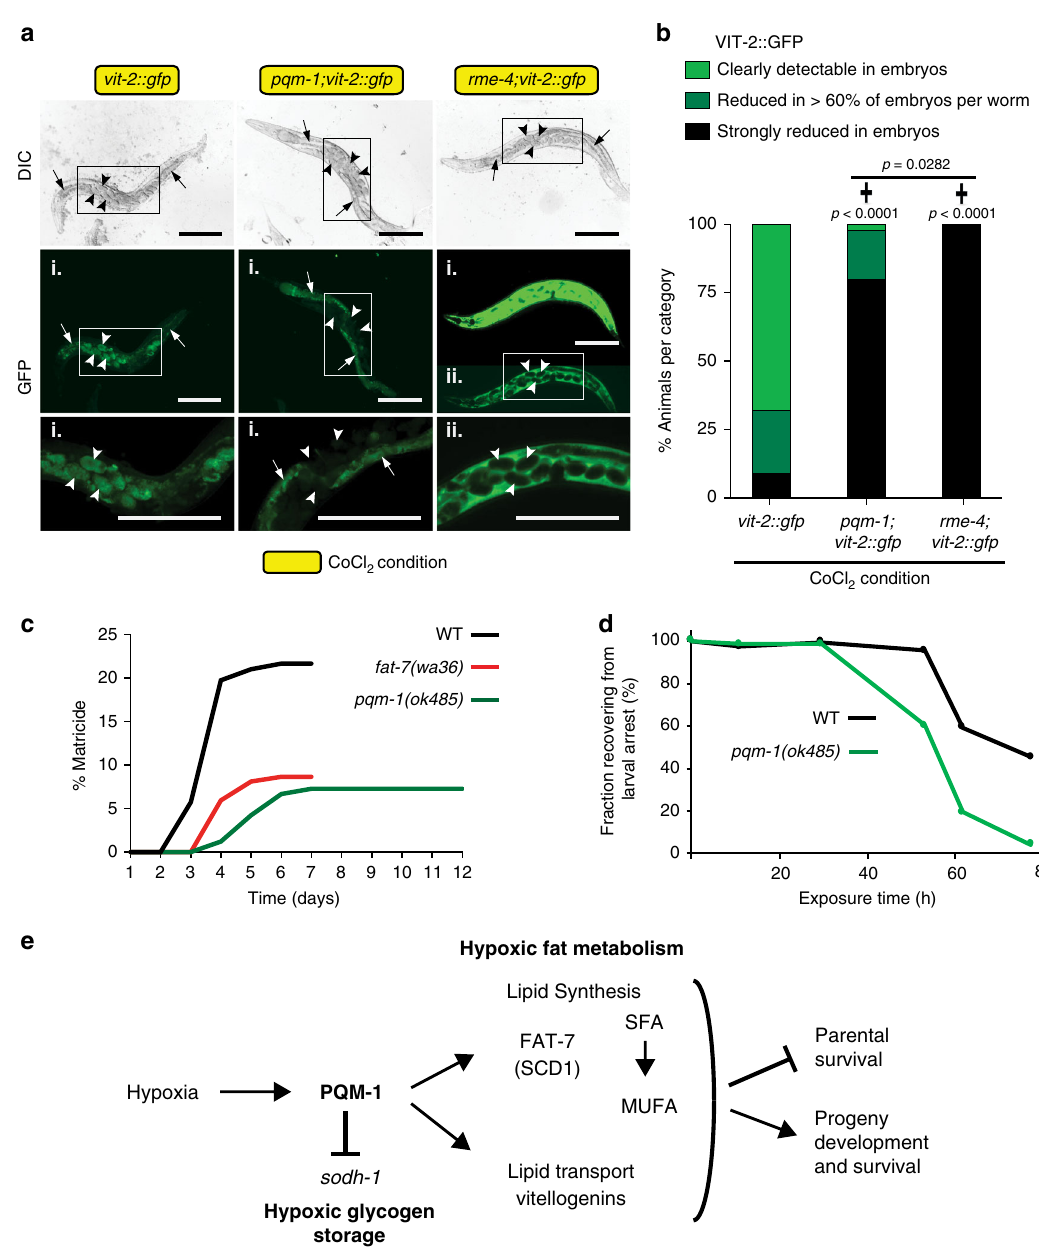
Fig. 6 PQM-1 activity promotes vitellogenesis, matricide and progeny survival in hypoxic stress. a , b Effect of pqm-1 loss on VIT-2::GFP levels in embryos ( a ) and quanti fi cation of VIT-2::GFP localization in embryos ( b ). Animals were synchronized at the L4 larval stage and exposed to 5 mM CoCl 2 at the day 1 of adulthood stage for 24 h. i and ii indicate long and short exposure times, respectively. Arrows point to intestine; arrowheads point to embryos; scale bars: 200 µ m. vit-2::gfp ( n = 53), pqm-1(ok485);vit-2::gfp ( n = 51), rme-4(b1001);vit-2::gfp ( n = 32). Chi-square analysis was performed. ( ✝ ) Indicates mutant versus wild type vit-2::gfp expressing strain, three independent experiments. c Matricide analysis of C. elegans strains exposed to 5 mM CoCl 2 at the L4 larval stage. WT ( n = 157), pqm-1(ok485) ( n = 165), fat-7(wa36) ( n = 185). d Survival analysis of progeny originating from CoCl 2 exposed hermaphrodites. The ability to exit and survive a developmental arrest caused by CoCl 2 was analyzed after transferring arrested larvae to regular culture conditions. Chi-square analysis ( c , d ); c p -values for pqm-1(ok485) versus WT matricide timepoints: day 3 ( p = 0.0018), day 4, day 5 ( p < 0.0001), day 6 ( p = 0.0001), day 7 ( p = 0.0002); fat-7(wa36) versus WT: day 3 (p = 0.0010), day 4 ( p = 0.0001), day 5 ( p = 0.0006), day 6 ( p = 0.0007), day 7 ( p